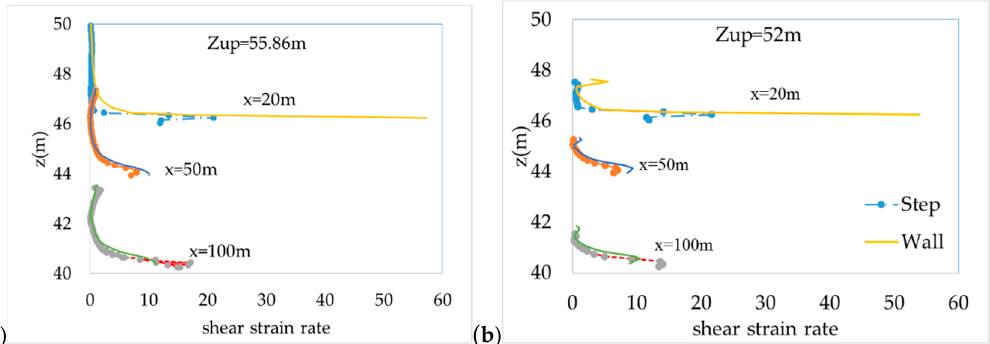
Figure 18. Shear strain rate magnitude distribution at three positions x = 20 m; 50 m; 100 m. ( a ) Z up = 55.86m; ( b ) Z up = 52m.